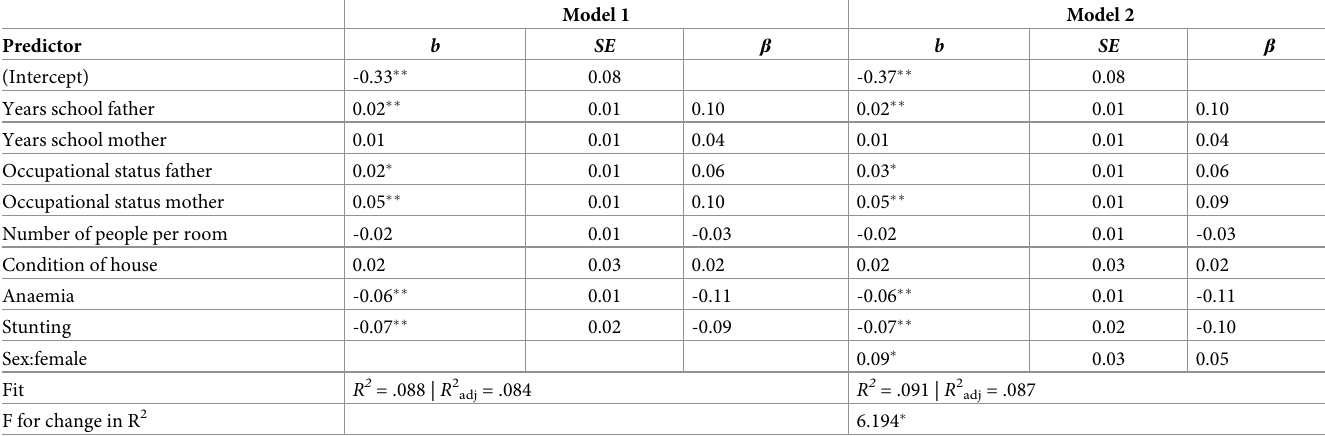
Table 3. Regression results for cognitive functioning at age 3 years predicted by early childhood risk factors (age 3 years) and sex.